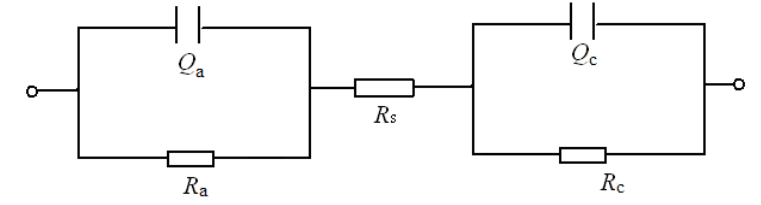
Figure 2. Equivalent circuit of the corrosion sensor embedded in the cement